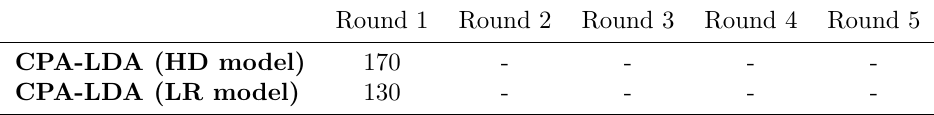
Table 2: Attack results for baseline methods (# traces for KGE ≤ 1) Round 1 Round 2 Round 3 Round 4 Round 5 CPA-LDA (HD model) 170